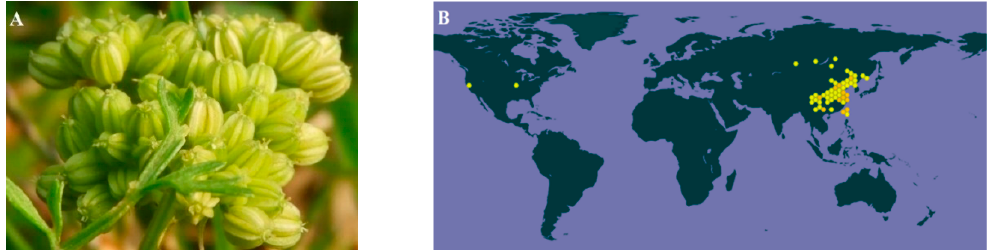
Figure 1. ( A ) The medicinal plant of Cnidium monnieri (L.) , created by Penny Wang and published by